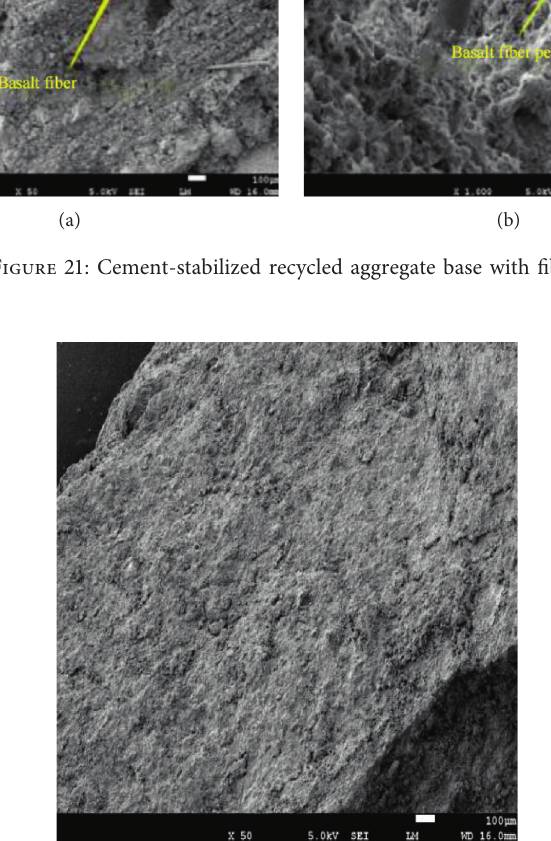
Figure 22: Cement-stabilized pure natural aggregate.